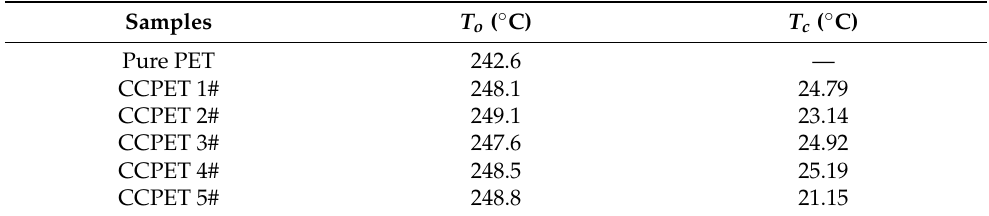
Table 5. This is a table. Tables should be placed in the main text near to the first time they are cited.